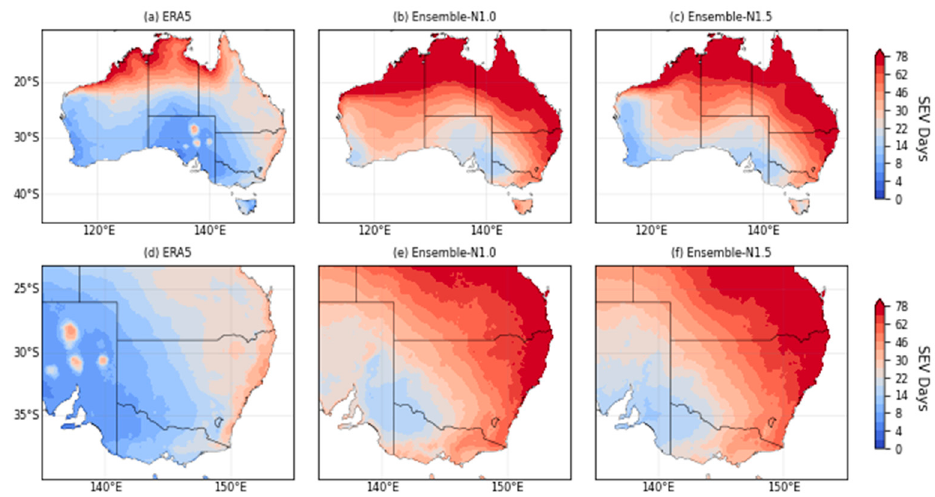
Figure 12. Number of days with TSTORM exceeding the severe thunderstorm threshold of 25,000 J kg − 1 m s − 1 for domain ( a – c ) d01 and ( d – f ) d02 from ( a , d ) ERA5, ( b , e ) N1.0 and ( c , f ) N1.5 during DJF.